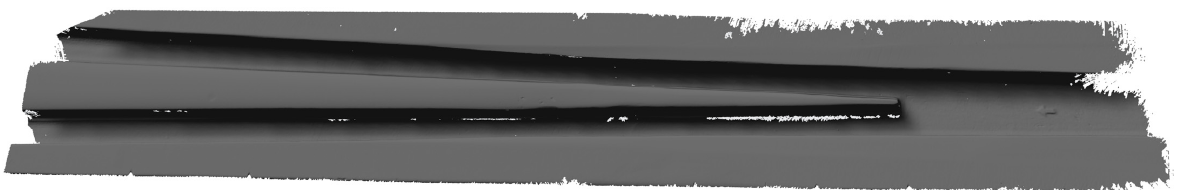
Figure 4. Post-processed, 2D, cross-section profiles ready for MBS analysis, crossing panel VAD 131. The longitudinal spacing between profiles is 10 mm. The crossing nose is to the left in the figure and the wing rail is to the right. 2.1.2. Post-Processed Crossing Rail Geometries Two examples of the post-processed, scanned crossing rail geometries are presented in Figure 5. In the figure, the dotted lines that intersect the crossing nose and wing rail surfaces are representative estimations for the lateral wheel–rail contact positions. The subfigures on the right show the extracted height profiles and their absolute difference in the approximated transition region. The two crossing rail geometries show different states of degradation of the running surface. The HO 22A geometry in the top of Figure 5 shows very few signs of geometry change, while VAD 131 (Figure 5, bottom) shows signs of significant geometry change. The height profile difference between the crossing rail and the wing rail at 500 mm from the crossing nose for HO 22A is around 3.5 mm, while for VAD 131 it is around 4.5 mm. Based on this significant profile difference in conjunction with the observed waviness of the rail surfaces, it is concluded that VAD 131 is in a severely degraded state.